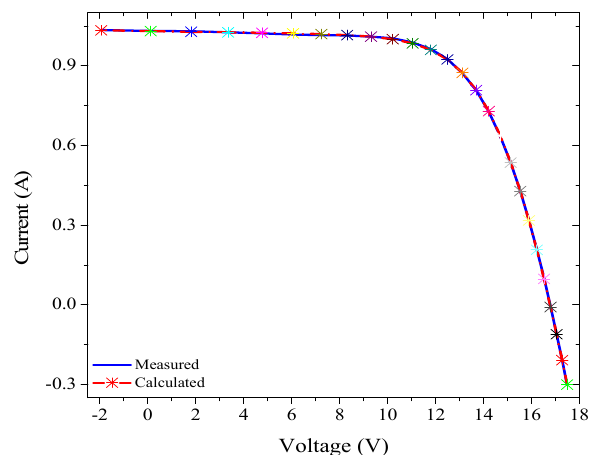
Figure 13. I–V curve of the measured and the calculated currents for the double-diode module.